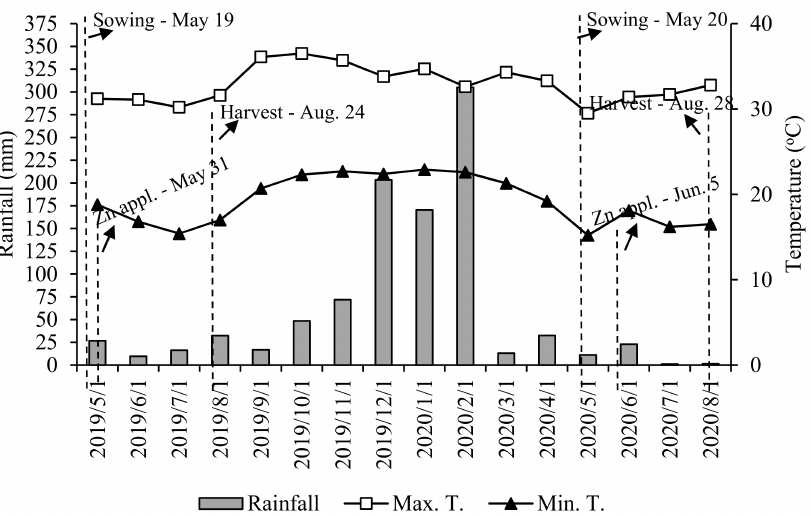
Figure 2. Rainfall maximum, average, and minimum temperatures and air relative humidity were acquired from the weather station of the Education and Research Farm of the Faculty of Engineering— UNESP during the common bean cultivation period from May to August 2019 and May to Au- gust